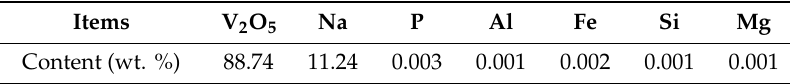
Table 2. Chemical composition of the as-obtained NaV 2 O 5 .